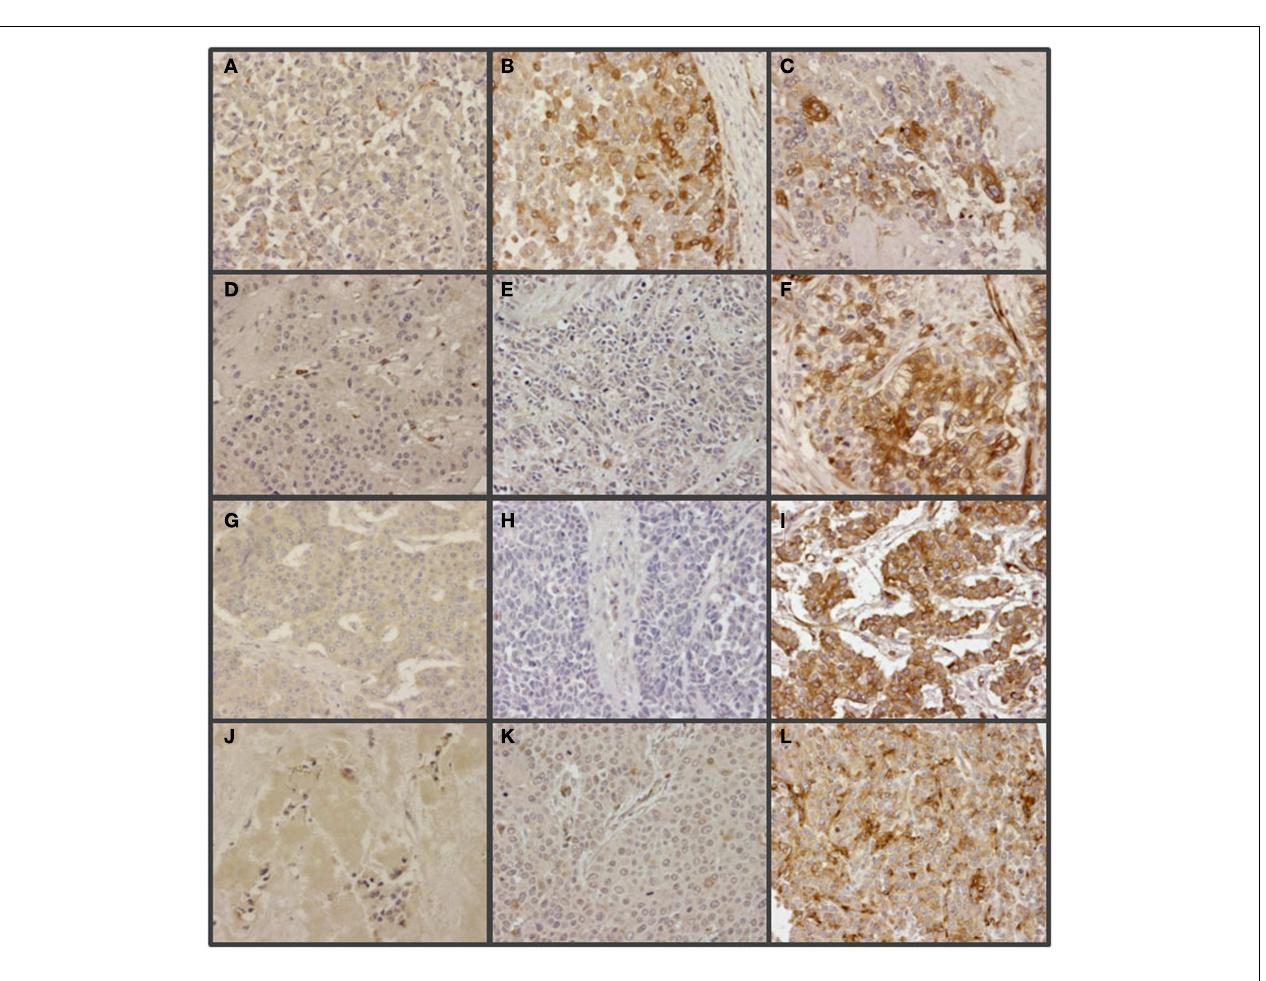
(C,E,F,H,I,K,L) Poorly differentiated NETs; tumors showing positive reaction from colon (C) , lung (F) , stomach (I) and pancreas (L) , and not expressing GPC5 from colon (E) , lung (H) and stomach (K) . Magnification 200 × .